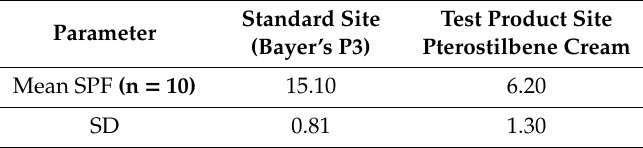
Table 4. Sun protection factor of pterostilbene